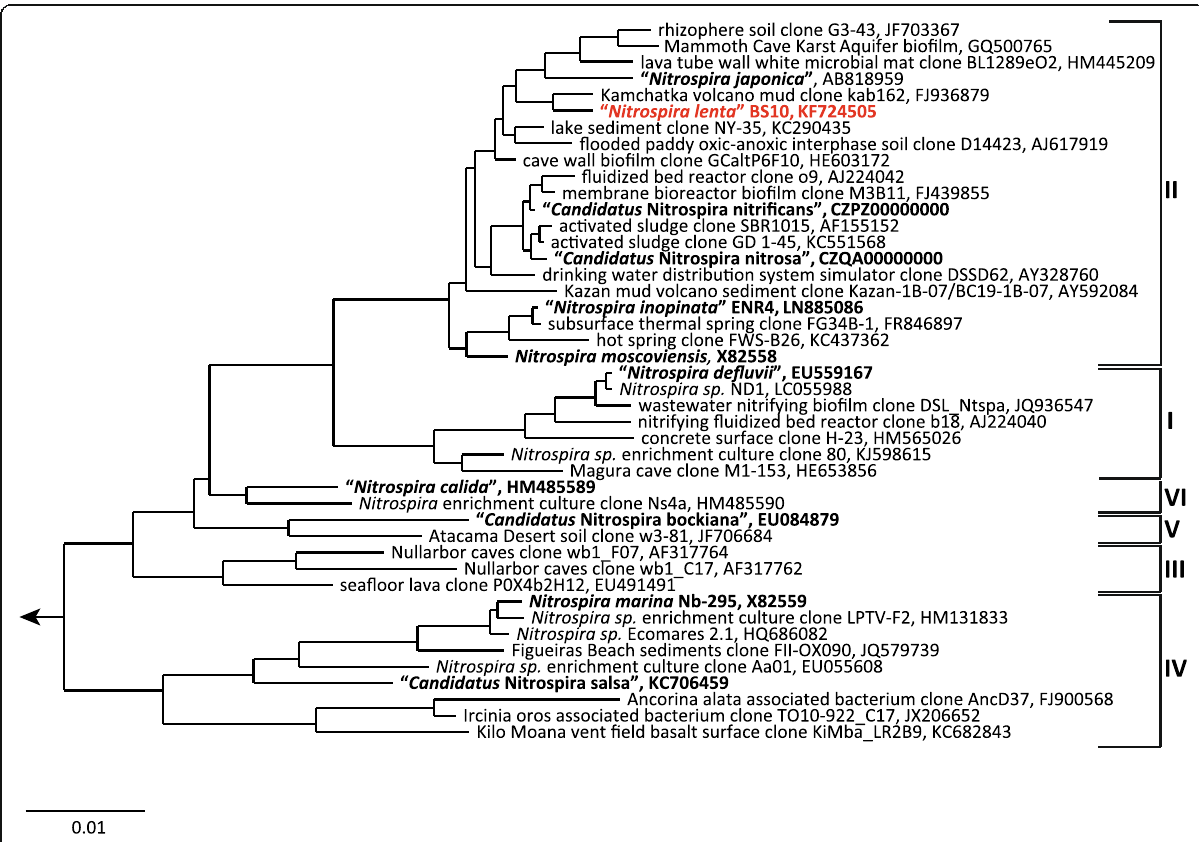
Fig. 1 Phylogenetic analysis of selected representatives from the genus Nitrospira . A 16S rRNA gene-based maximum likelihood tree is shown. Sequences of cultured representatives are printed in bold, “ N. lenta ” in red. The tree was constructed using sequences ≥ 1165 bp and a 50% conservation filter, resulting in 1463 valid alignment positions. Leptospirillum ferriphilum (AF356829) and L. ferrooxidans (X86776) were used as outgroup, which is indicated by the arrow. Scale bar indicates 1% estimated sequence divergence